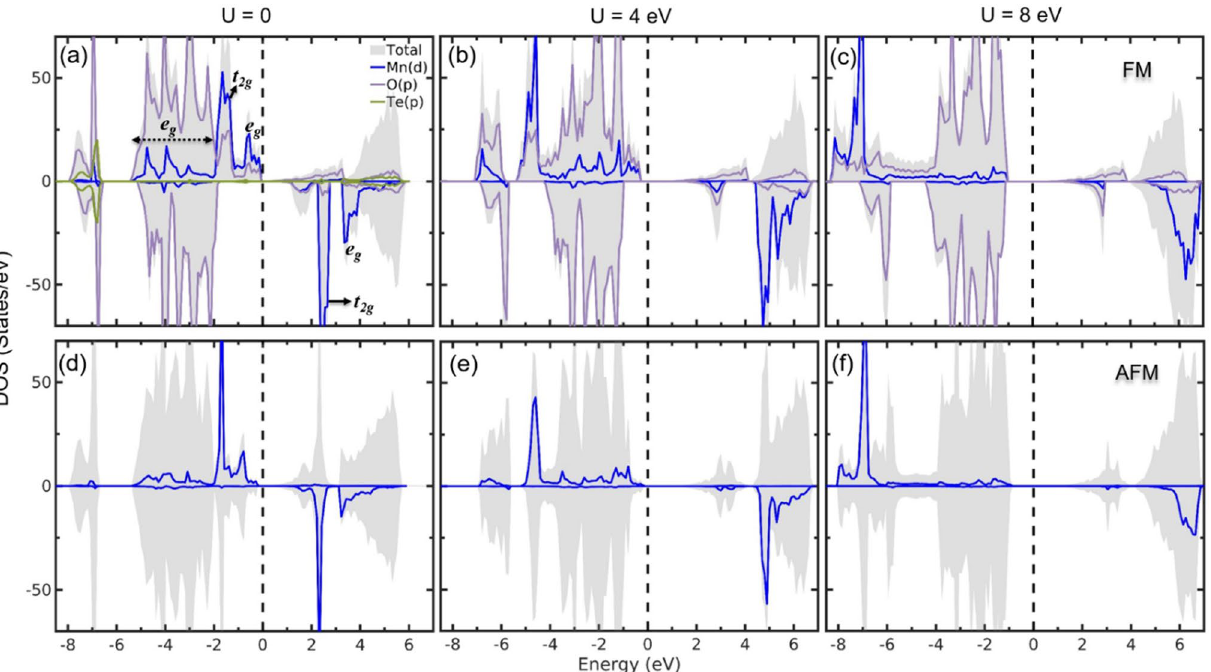
Figure 7. ( a ) The total and partial densities of states (DOS) for the ferromagnetic (FM) and the energetically most stable antiferromagnetic (AFM) configuration (AFM3, see Fig. 8e) as a function of the Hubbard U . For clarity, in the AFM configuration, the Mn- d states of only one spin-sublattice is shown. For the opposite spin- sublattice, the corresponding DOS is simply a mirror